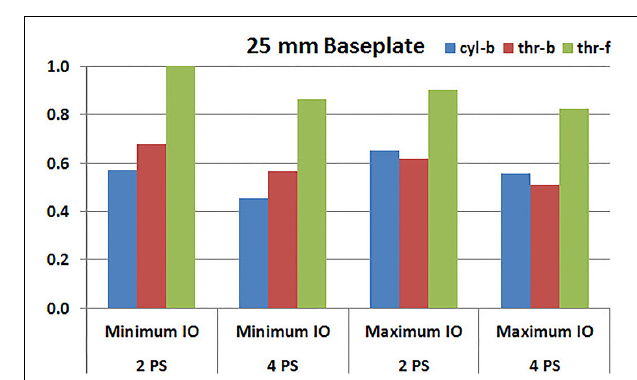
FIGURE 8 | Interfacial micromotion results of 25 mm diameter baseplate using two and four peripheral screws (2PS and 4PS); Minimum and Maximum inferior offset (Minimum IO and Maximum